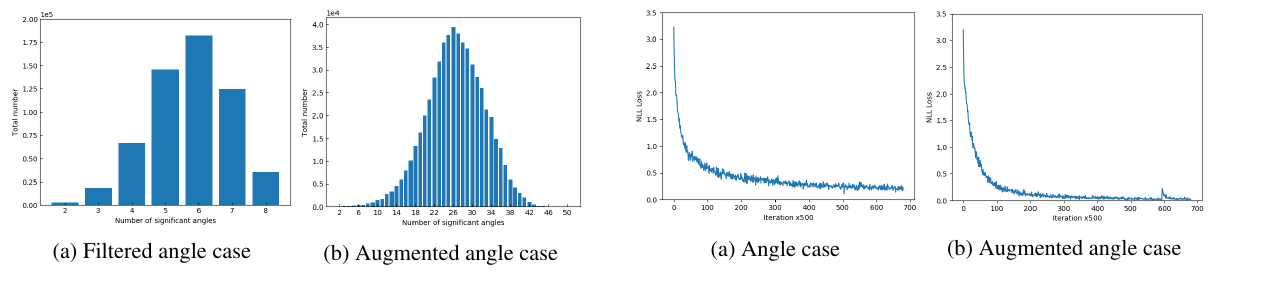
Figure 9. Number of angles in the original trajectory after filtering small angles and the augmented trajectory after inserting virtual nodes.